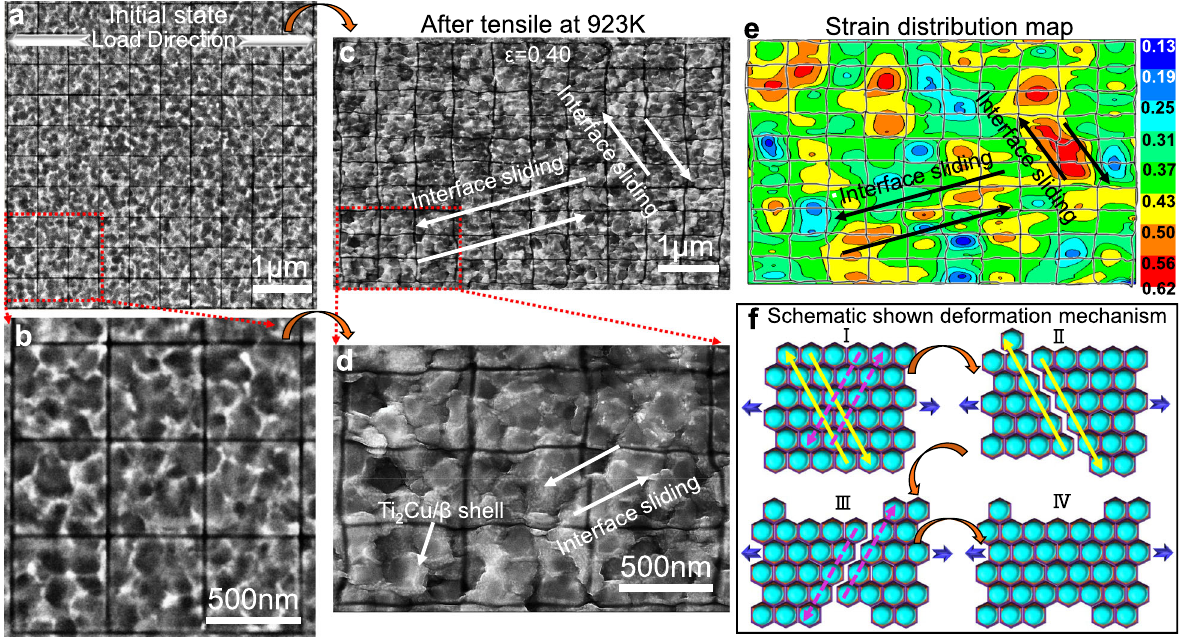
Fig. 4 In-situ scanning electron microscopy (SEM) observation performing on a fi ducial marked sample in the 923 K tensile test. a , b SEM images of the sample before tensile test, shells of α grains can be viewed. c , d SEM images of the sample after tensile to the strain of 0.4, the bending of fi ducial markers denotes phase interface sliding taking place. e A strain distribution map, regions with larger strains correspond to where signi fi cant phase interface slip happens. f Schematic fl owchart of the superplastic mechanism in the Ti6Al4V5Cu alloy: I, Initial state; II, Phase boundary sliding in one tangential direction (yellow arrows); III, Phase boundary sliding in another equivalent tangential direction (purple arrows); IV, Alternating phase boundary sliding in different tangential directions sustains superplastic deformation along the loading direction, while Ti 2 Cu/ β shells suppress grain coarsening during the